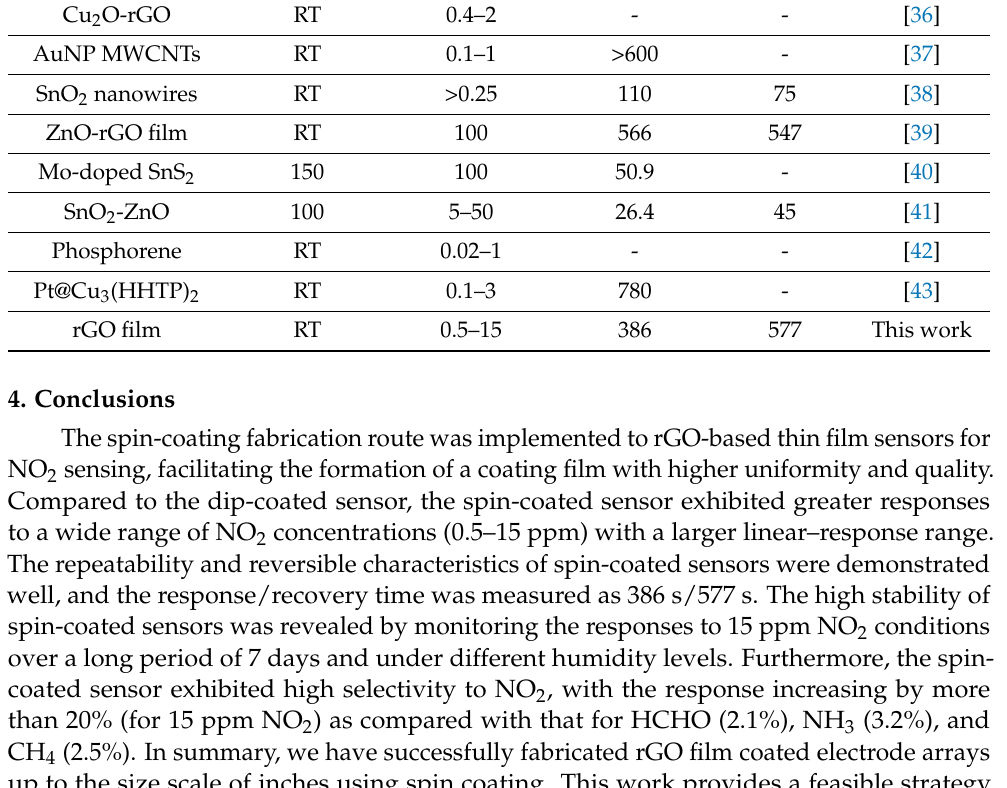
Table 1. Gas sensing properties of sensors for detecting NO 2 gas (RT: Room temperature).